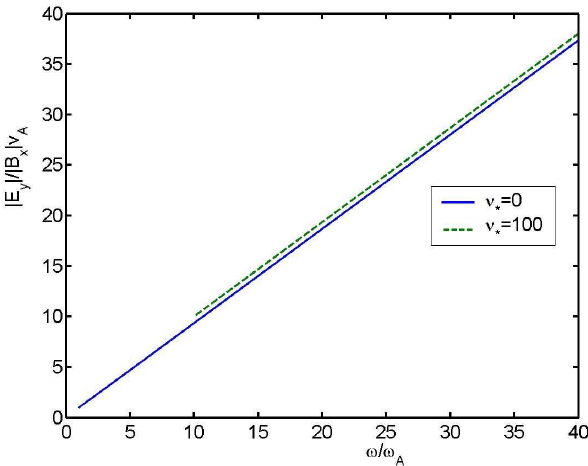
Fig. 6. Same as Fig. 5 but for the particle number density